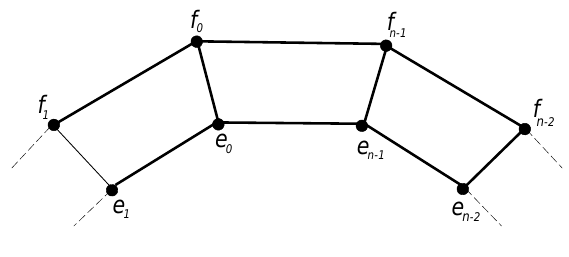
Figure 1. The graph of D n